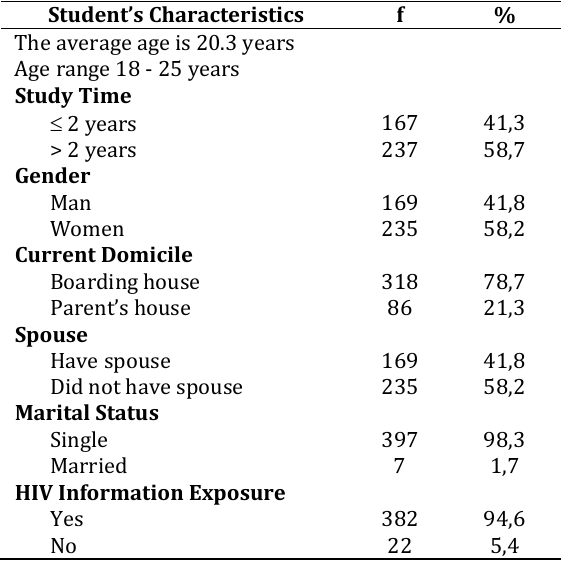
Table 1. University Student’s Characteristics (n = 404) Student’s Characteristics